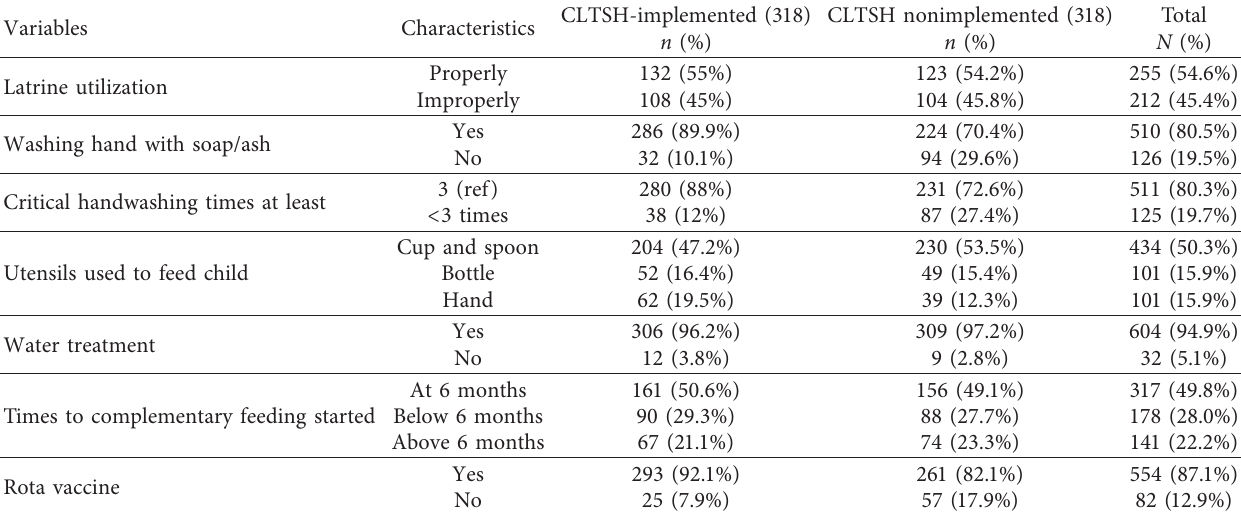
Table 4: Behavior-related characteristics in selected CLTSH implemented and nonimplemented woreda in Gamo Gofa Zone, 2018.